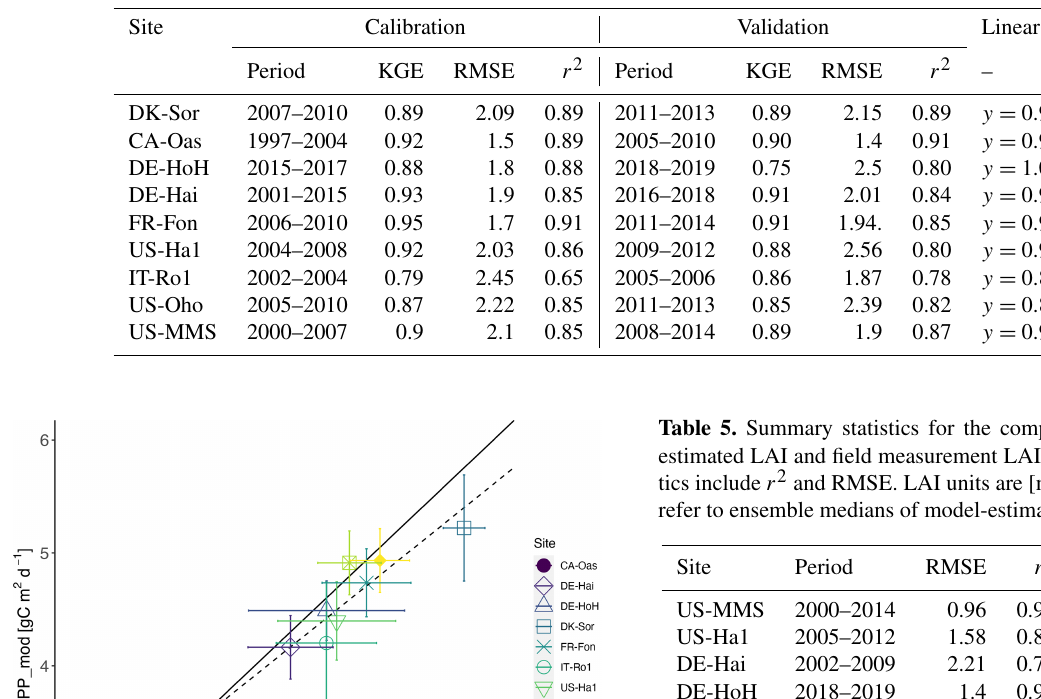
Table 4. Summary statistics for the comparison between model-estimated GPP and tower-estimated GPP at different sites. Statistics include KGE, root-mean-square error (RMSE), and r 2 . GPP units are [gCm − 2 d − 1 ]. The statistics refer to ensemble medians of model-estimated GPP. The linear regression is over both the calibration and validation periods.